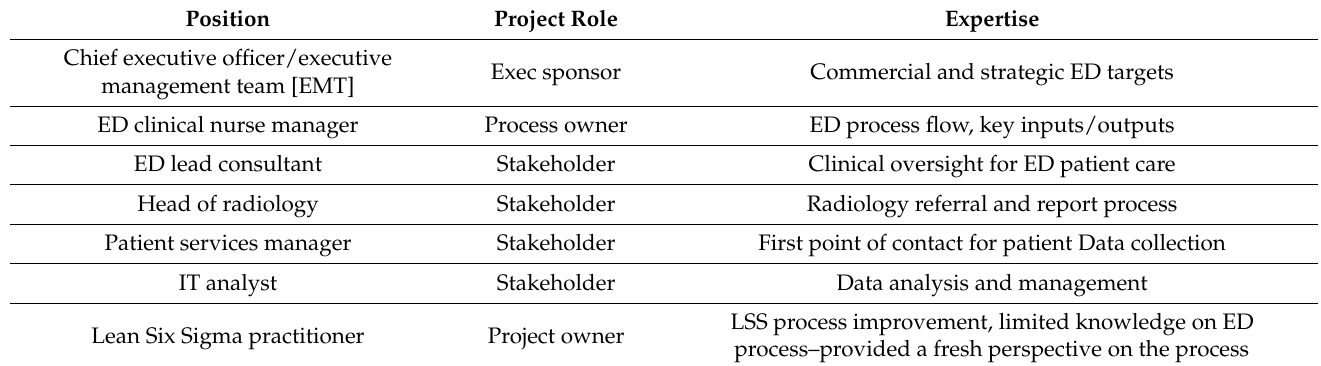
Table 3. Project